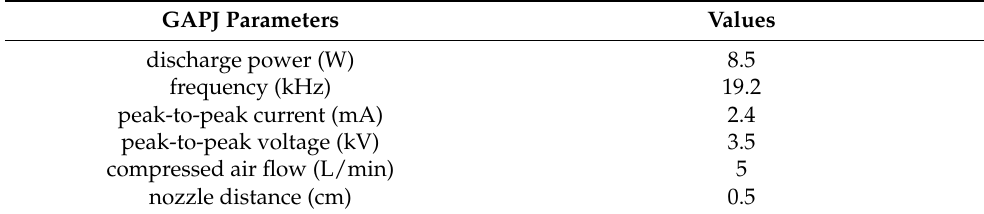
Figure 1. Gliding arc plasma jet experimental setup for treatment of F. graminearum (FML08) and F. meridionale (FML03). A photo depicting the setup of the plasma jet used for treatment was added to the figure. Table 1. Gliding arc plasma jet (GAPJ) parameters.